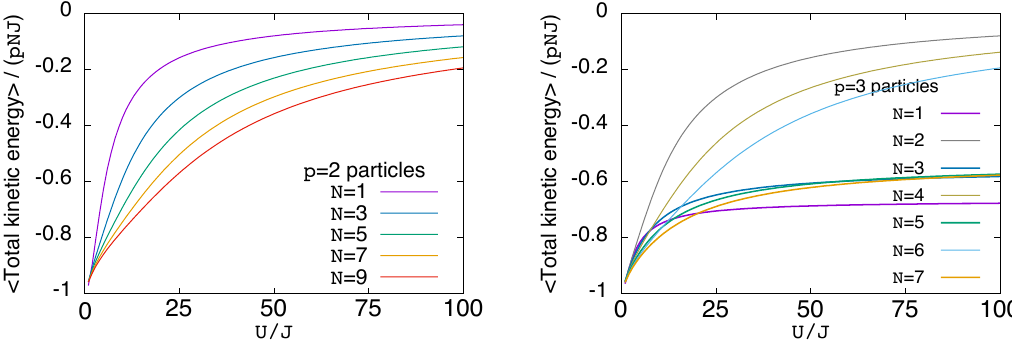
Figure 8 . Left: numerical plot of the e(cid:11)ective hopping with 2 particles per species. Only the cases with odd values of N is plotted, but for an even N , the value appears between the plots for neighboring odd numbers. Mott insulator phase appears in this system of even number of particles at the large U limit. Right: numerical plot of the e(cid:11)ective hopping with 3 (cid:12)xed particles. The VEV is non-zero at large U in the system of odd number of particles and odd number of components N . Otherwise, the VEV decreases to zero at large U